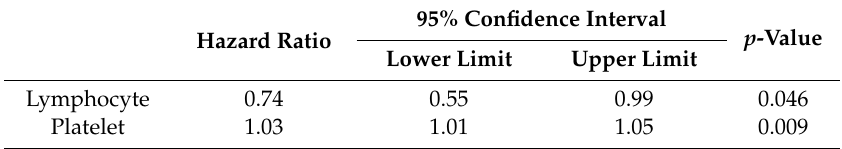
Table 2. Results of multivariate analysis to predict overall recurrence (disease free survival,